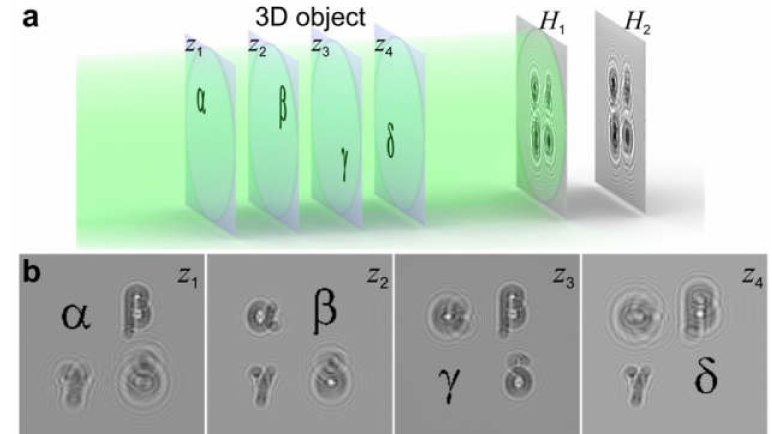
Figure 24. Reconstruction of 3D objects from two or more intensity measurements. ( a ) Experimental arrangement, in which the 3D sample is represented by a set of planes at di ff erent z -positions and two holograms are acquired at di ff erent distances from the sample, H 1 and H 2 . ( b ) Reconstructed amplitude distributions at four planes within the 3D sample distribution. Adapted from